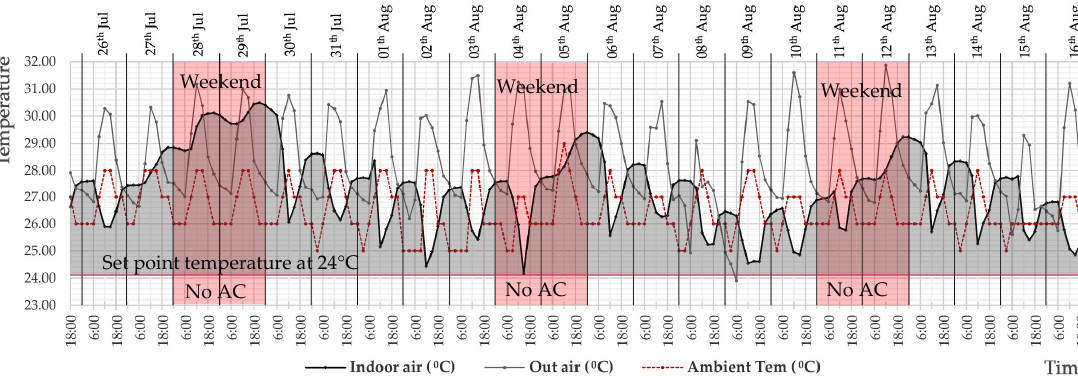
Figure 7. Building “B”: Hourly severe heat stress behavior in terms of air temperature on the 8th floor over a period of 20 days in July–Aug 2018; indoor air moved well above set point temperature.